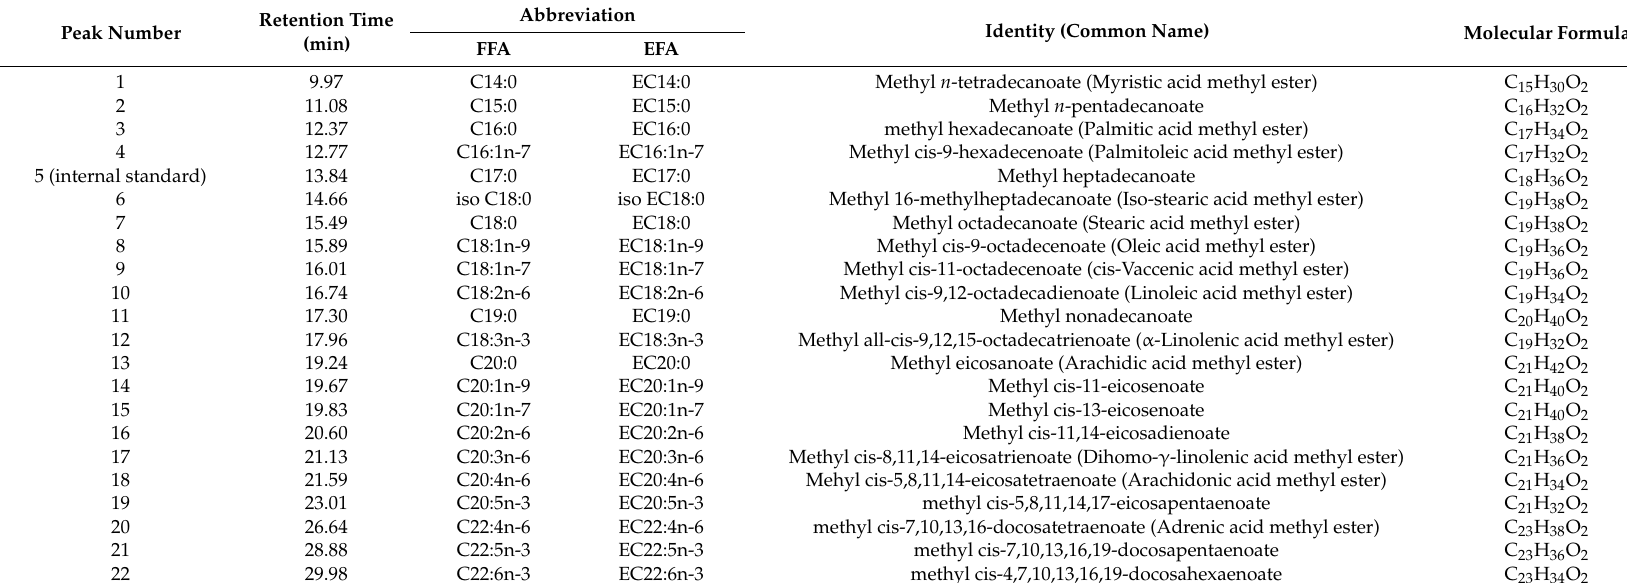
Table 2. Identification of FFAs and EFAs from the rat serum analyzed by